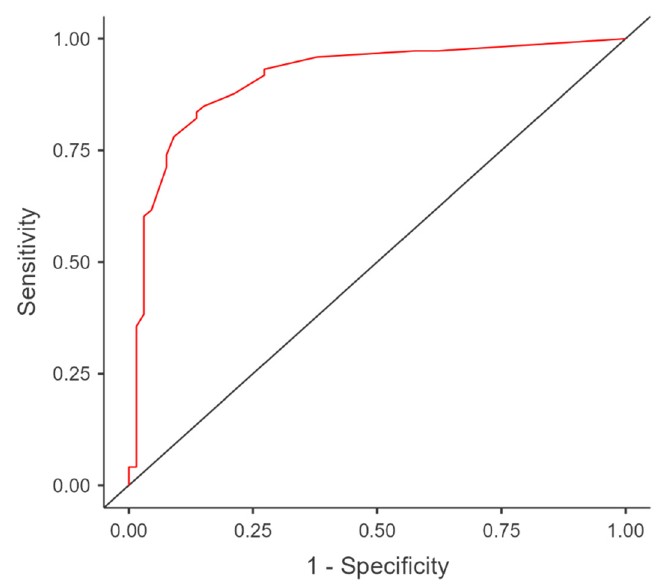
Figure 1. ROC curve for the logistic regression model (AUC = 0.91). ROC, receiver operating characteristic; AUC, area under the ROC curve.